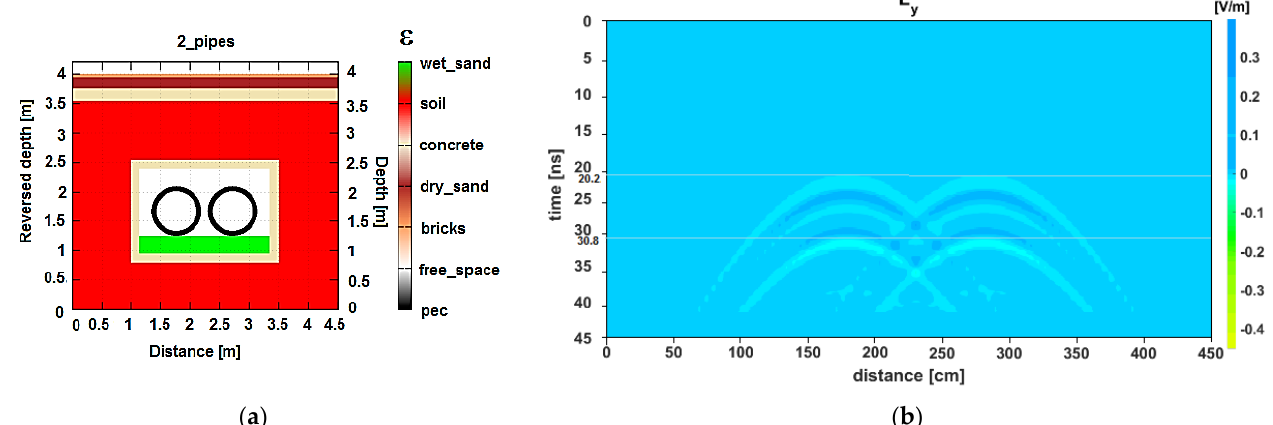
Figure 6. Simulation using GPRMax 2D ( a ) the simulated geometry and visualization using GPRMaxGV Gnuplot viewer; ( b) Signal processing of simulated data.